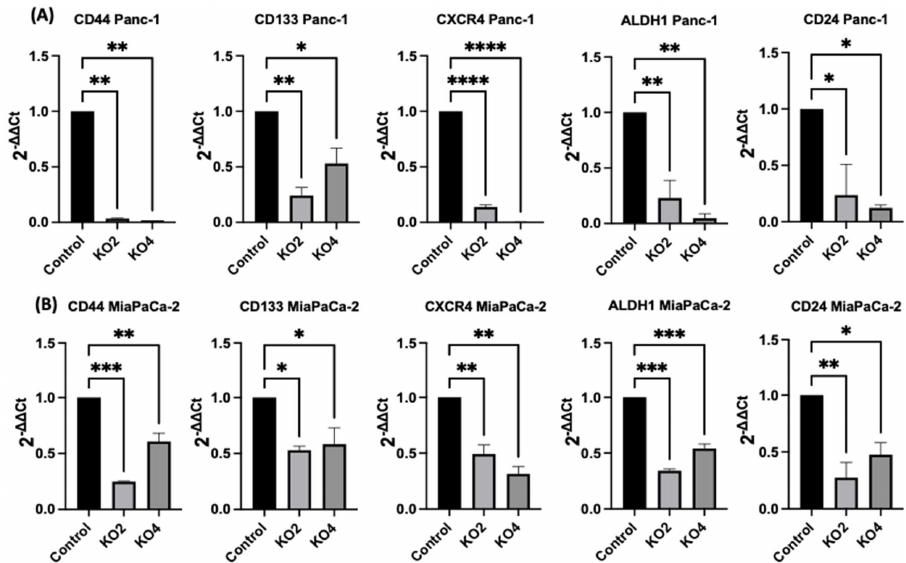
Figure 4. Expression of CSCs markers in PDAC cell lines following miR-21 knockout. ( A ) mRNA expression levels of CD44, CD133, CXCR4, ALDH1, and CD24 in the Panc-1 miR-21 KO cell line, compared with the Panc-1 vector alone. Relative mRNA expression levels of CD44, CD133, CXCR4, ALDH1, and CD24 are significantly reduced in miR-21 KO Panc-1 cells. The column graphic repre- sents the average of three replicates of RNA isolated from Panc-1 control and its Kos. Data normal- ized according to RPII expression by fold analysis ( n =3, p < 0.05). ( B ) mRNA expression levels of CD44, CD133, CXCR4, ALDH1, and CD24 in the miR-21 KO MiaPaCa-2 cell line, compared with MiaPaCa-2 vector alone. Relative mRNA expression levels of CD44, CD133, CXCR4, ALDH1, and CD24 are significantly reduced in miR-21 KO MiaPaCa-2 cells. The column graphic represents the average of three replicates of RNA isolated from MiaPaCa-2 control and its Kos. Data normalized according to RNA polymerase II (RPII) expression by fold analysis ( n =3, p < 0.05). p -values are in- dicated as * p ≤ 0.05; ** p ≤ 0.01; *** p ≤ 0.001; **** p ≤ 0.0001; error bars indicate SD.